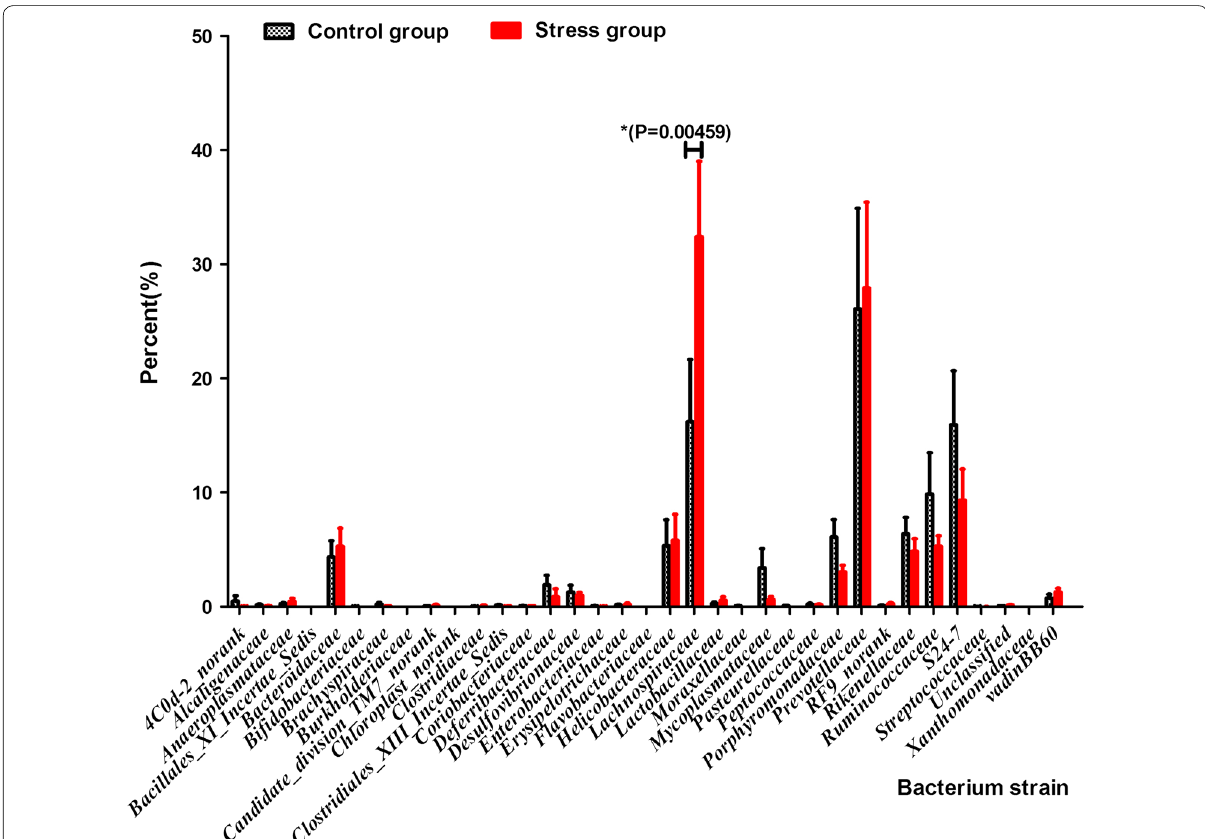
Fig. 7 Figure of community analysis. Data are expressed as the mean